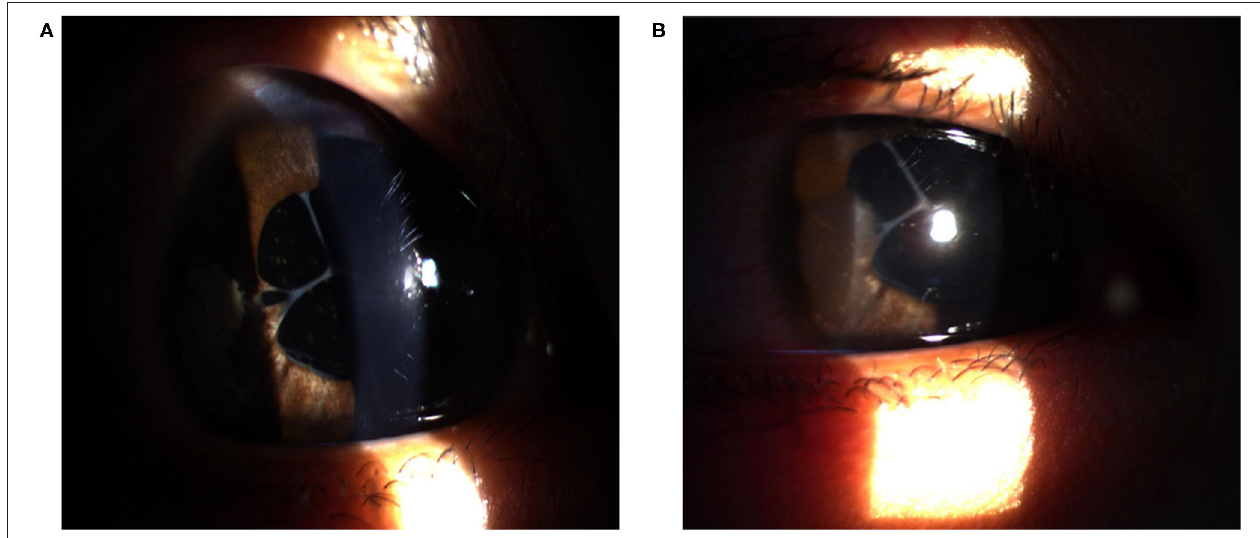
FIGURE 4 | Slit-lamp image of the cornea after surgery. The optical zone was clear and transparent after 1 week (A) and 3 months (B) . could precisely remove corneal deposits without manual